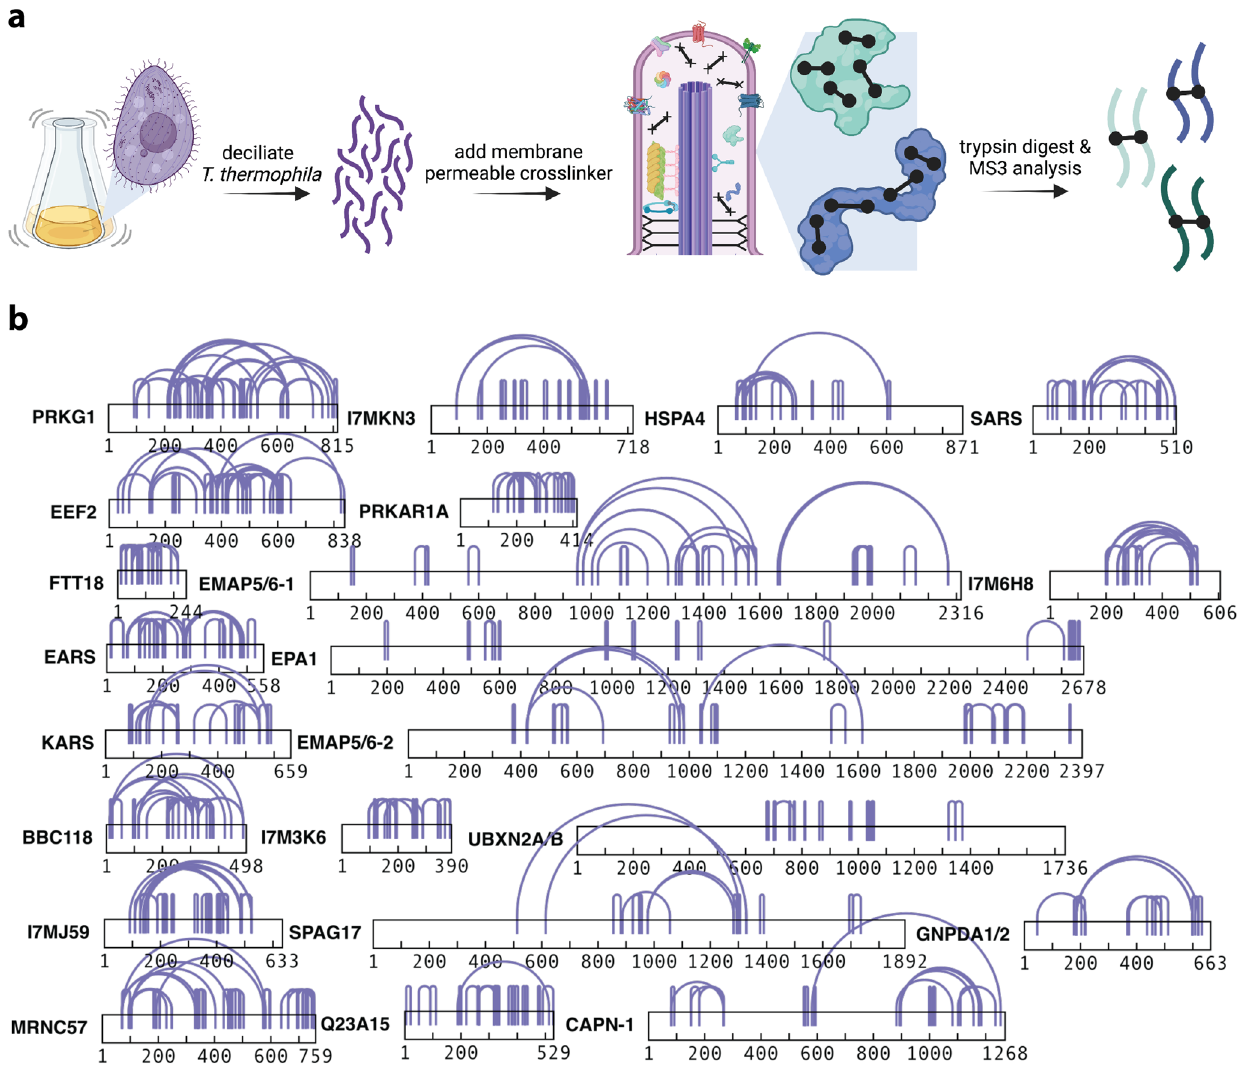
Fig. 1 Chemical cross-linking of isolated ciliary proteins provides abundant intramolecular cross-links. a Schematic of the protocol used to determine chemical cross-links among Tetrahymena thermophila ciliary proteins, from cell culture through ciliary isolation, incubation with the membrane-permeable cross-linker DSSO, to the use of tandem (MS 1 /MS 2 /MS 3 ) mass spectrometry to identify the speci fi c cross-linked peptides. Created with BioRender.com. b Examples of the most extensively intramolecularly cross-linked proteins observed. The corresponding Uniprot identi fi ers and amino acid sequences are provided for all proteins discussed in the supporting Zenodo archive, along with the precise locations of